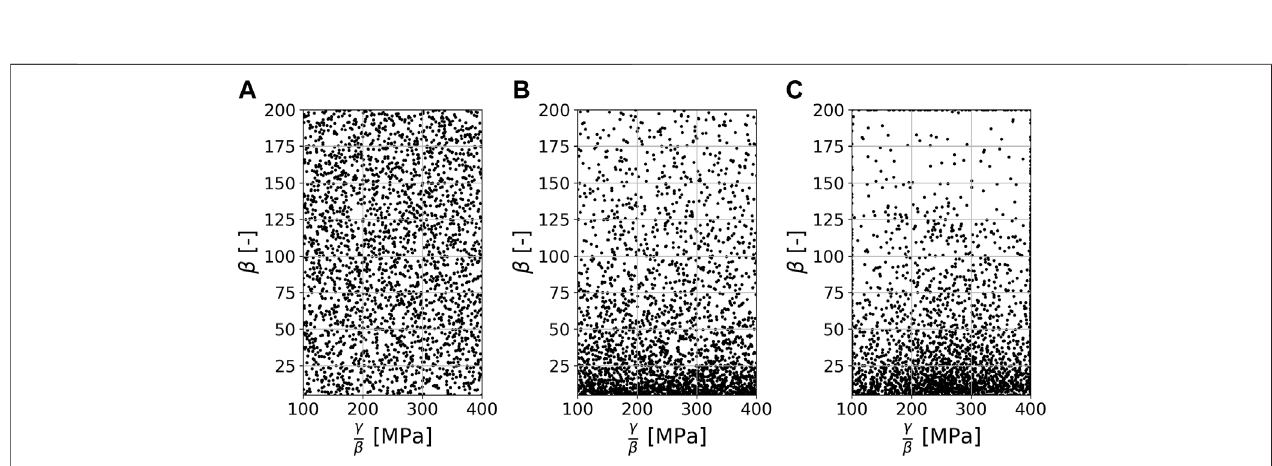
FIGURE 5 | The sampled parameter space of the hardening model described in Eq. 7 . 2,500 samples were generated using Latin hypercube design (A) , the knowledge-based sampling approach following Morand and Helm (2019) (B) and query-by-committee (C) .